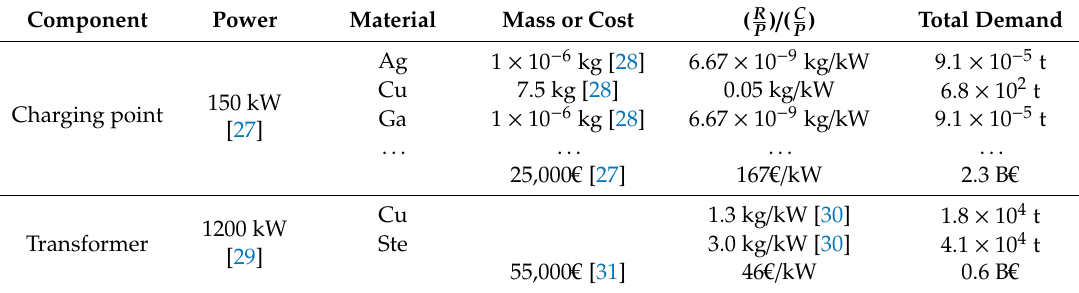
Table 3. Exemplary raw material and investment demand for charging points for SoA.